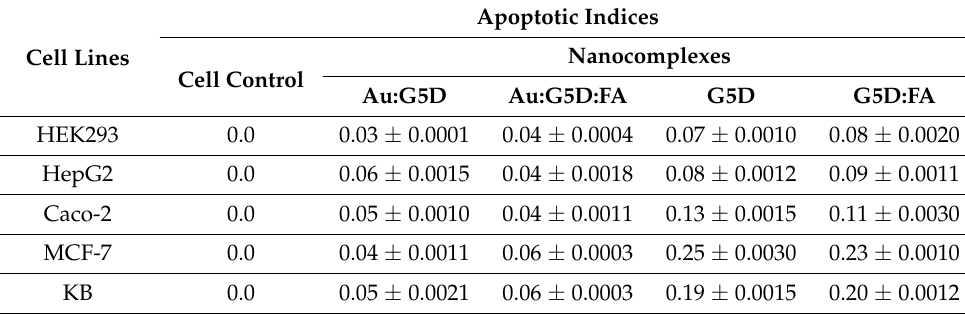
Table 2. Apoptotic indices of nanocomplexes in selected cell